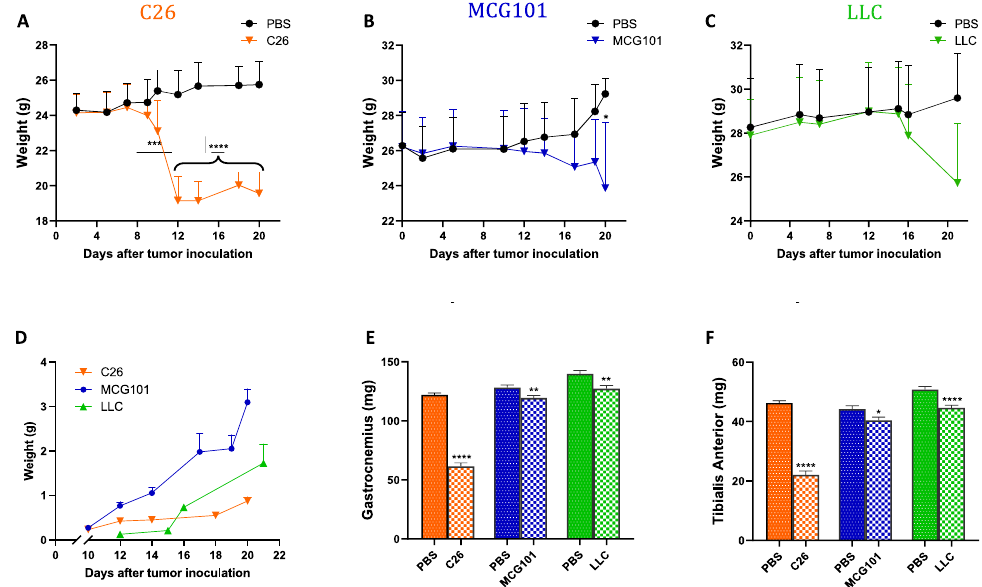
Figure 1. Different tumors induce body weight loss and muscle wasting in mice with different timing and tumor growth rate. In orange, 9–10 week-old male C26-bearing BALB/c mice start losing body weight already after 10 days from tumor injections and have lost 20% of body weight 12 days later, n = 9–10 ( A ). In blue, 9–10 week-old male MCG101-carrying C57BL6/J mice lose about 10% of their initial body weight after 20 days from tumor inoculation, n = 10–11 ( B ). In green, 9–10 week-old male LLC-bearing C57BL6/J mice present about 8% body wasting after 20 days, but this was not significant, n = 10 ( C ). Two-way ANOVA, * p ≤ 0.05, *** p ≤ 0.001, **** p ≤ 0.0001. In black, PBS-injected mice are indicated as controls ( A – C ). Tumor weights measured manually with a caliper over time are plotted ( D ). Ordinary one-way ANOVA, Tukey’s multiple comparisons test, not significant, n = 10–11. The weights of gastrocnemius ( E ) and tibialis anterior muscles ( F ) are reduced in all the tumor-bearing mice, but to different extents. In orange, C26 n = 18–20, in blue, MCG101 n = 20–22 and in green, LLC n = 20. Unpaired t -test, * p ≤ 0.05, ** p ≤ 0.01, **** p ≤ 0.0001.